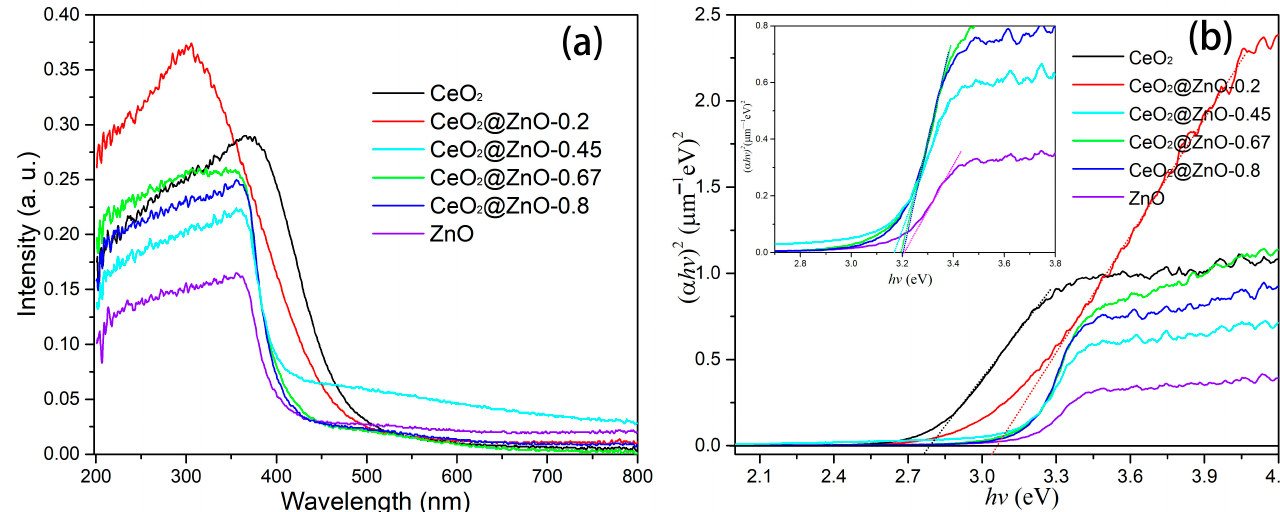
Figure 6. ( a ) UV-visible absorption spectra and ( b ) plots of ( α h ν ) 2 vs. h ν for the CeO 2 , ZnO, and